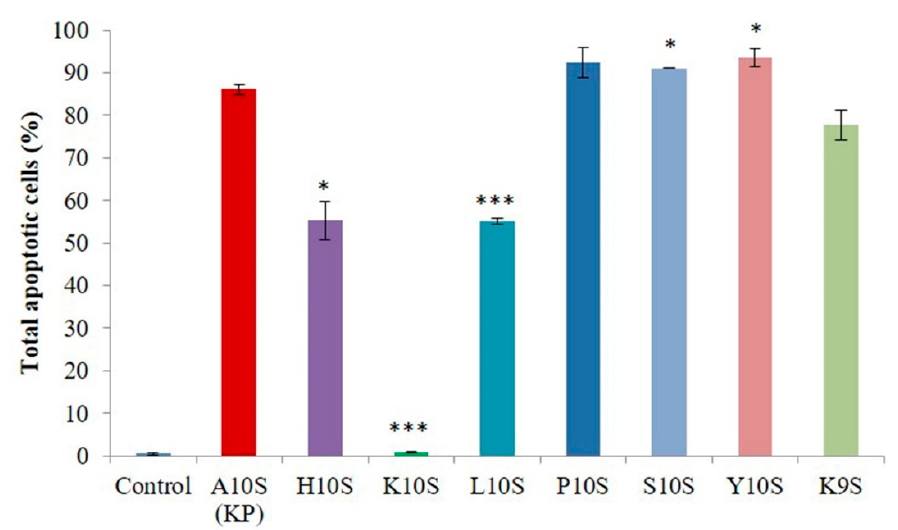
Figure 6. Apoptotic effects of treatment with KP and its derivatives in Candida albicans SC5314 cells. Yeast cells were treated for 30 min with peptides at 2 × their EC 50 values. Data, expressed as percentage of apoptotic cells on the total gated cells, represent the mean ± standard deviation from at least two independent experiments (* p < 0.05, *** p < 0.001 vs. KP-treated cells).